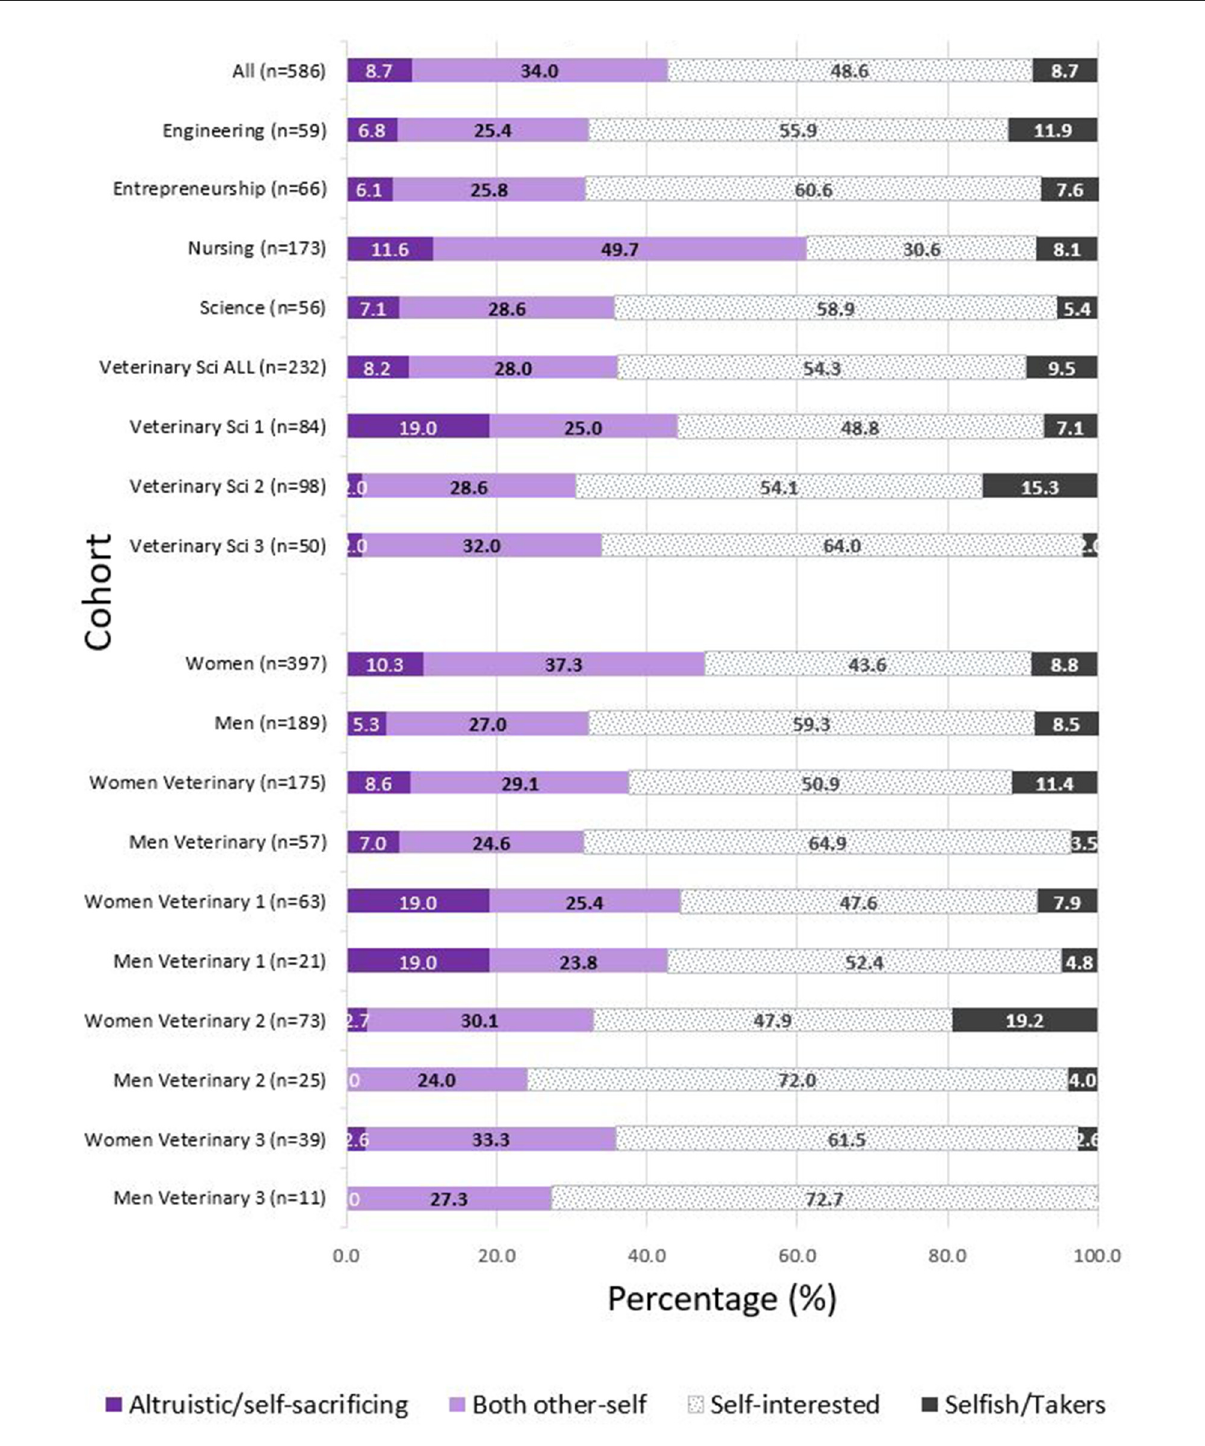
FIGURE4 Proportional representation of the four clusters for the disciplinary cohorts of the study population ( n =